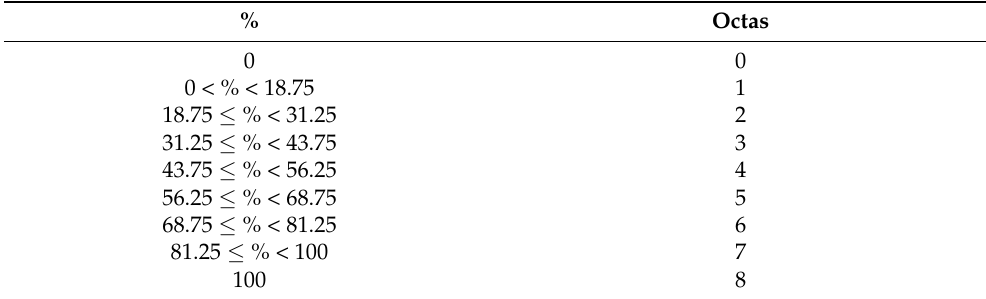
Table 1. Conversion table from cloud amount expressed in percentage to cloud amount expressed in octas [13]. % Octas 0 0 0 < % <